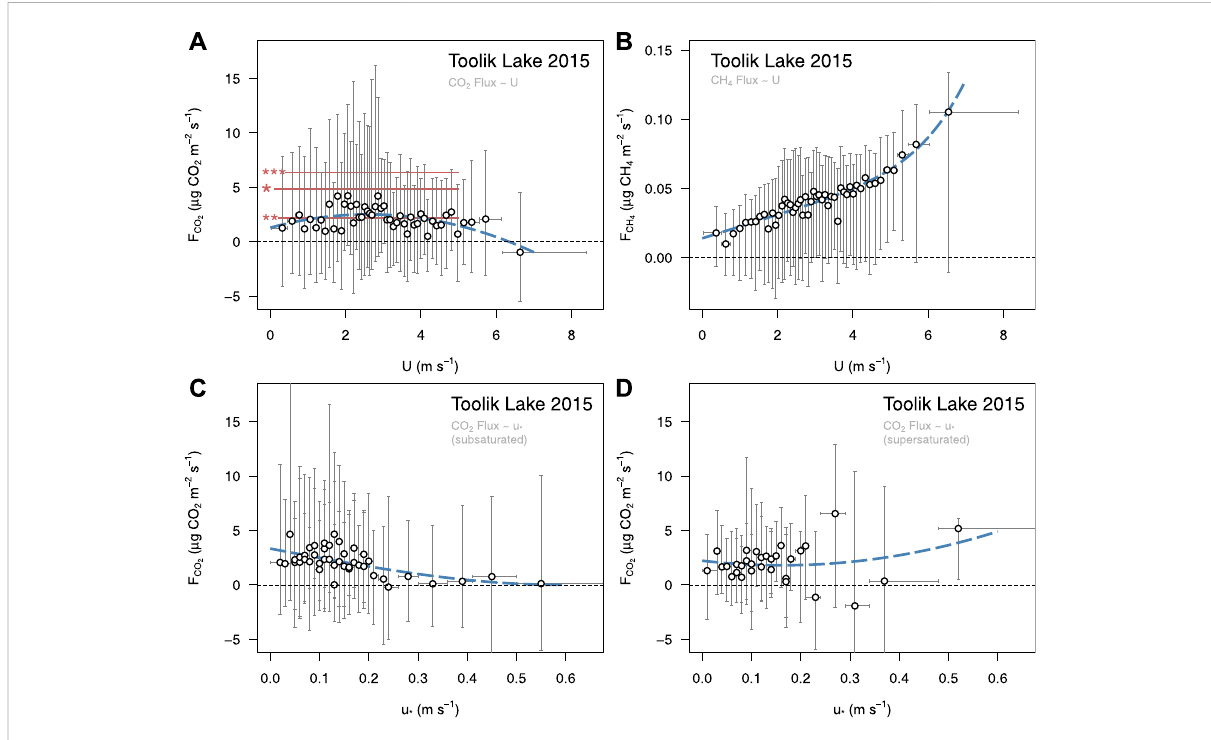
FIGURE 5 CO 2 fl ux (A) and CH 4 fl ux (B) at 5-min resolution as a function of mean horizontal wind speed, and CO 2 fl ux as a function of friction velocity u * withsubsaturatedwater (C) andsupersaturatedwater (D) .Thered linewithin (A) showstheEugsteretal.(2003) average fl uxlevel determinedovera fewdays(*),duringstrati fi edconditions(**),andduringconvectiveperiods(***).Verticalerrorbarsshowtheinter-quartilerangeofvalues(inner50% of data), whereas the horizontal whiskers show the entire size of the associated